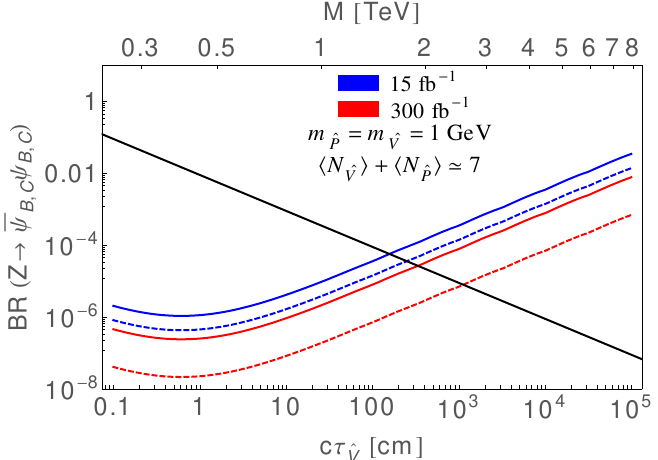
Figure 6 . Projected limits on BR( Z ! ) from the search for single ^ V ! (cid:22)(cid:22) DV B;C B;C inside an emerging jet at LHCb. Solid (dashed) lines correspond to the standard background count (a background-free scenario). The black line corresponds to the theoretical prediction, BR (cid:25) 9 (cid:2) 10 (cid:0) 3 = ( c(cid:28) ^ = cm), as derived from eqs. (3.2) and V